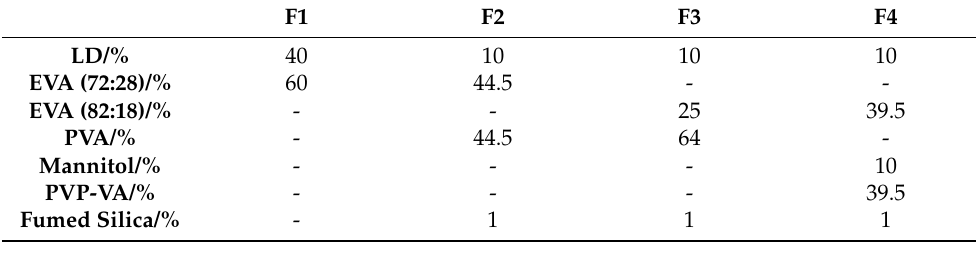
Table 5. Formulation development of SR LD-EVA formulation.